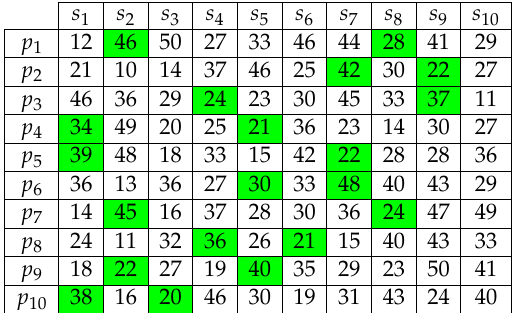
Table 2. Illustrative example of stochastic TEP. Numerical values represent social welfare of 10 transmission plans under 10 scenarios. For each transmission plan, we used the scenario selection algorithm in Section 3.3 to select two high-quality scenarios, whose social welfare values are highlighted in